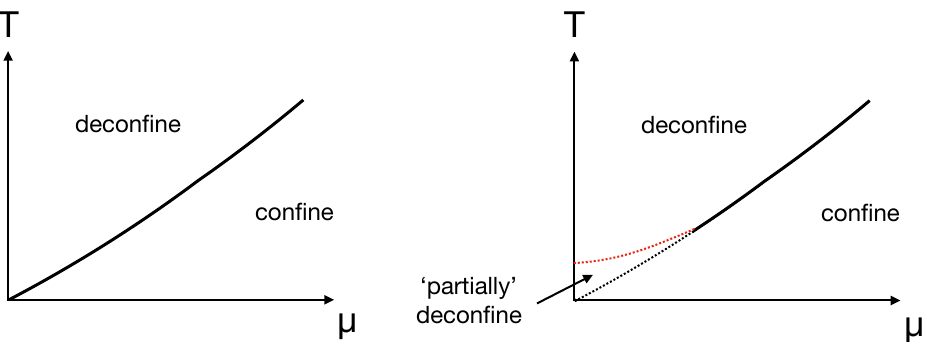
Figure 19. Two kinds of conjectured phase diagrams of the BMN matrix model in the canonical ensemble. The vertical axis is the temperature T . The large- (cid:22) region admits perturbative calcula- tion [46, 47] and the transition is found to be of (cid:12)rst order. The small- (cid:22) region has been studied by using the dual gravity description [42], but the order of the transition has not been established. See refs. [48, 49] for lattice simulations along this